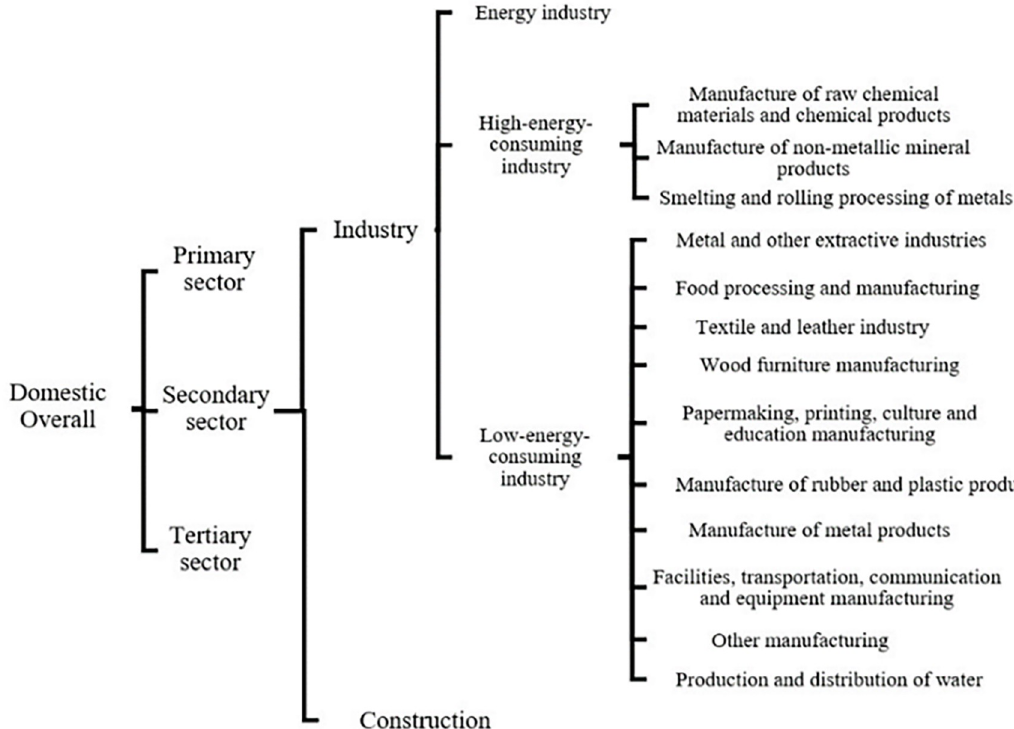
Fig 1. Hierarchy of the calculation of the industrial energy rebound